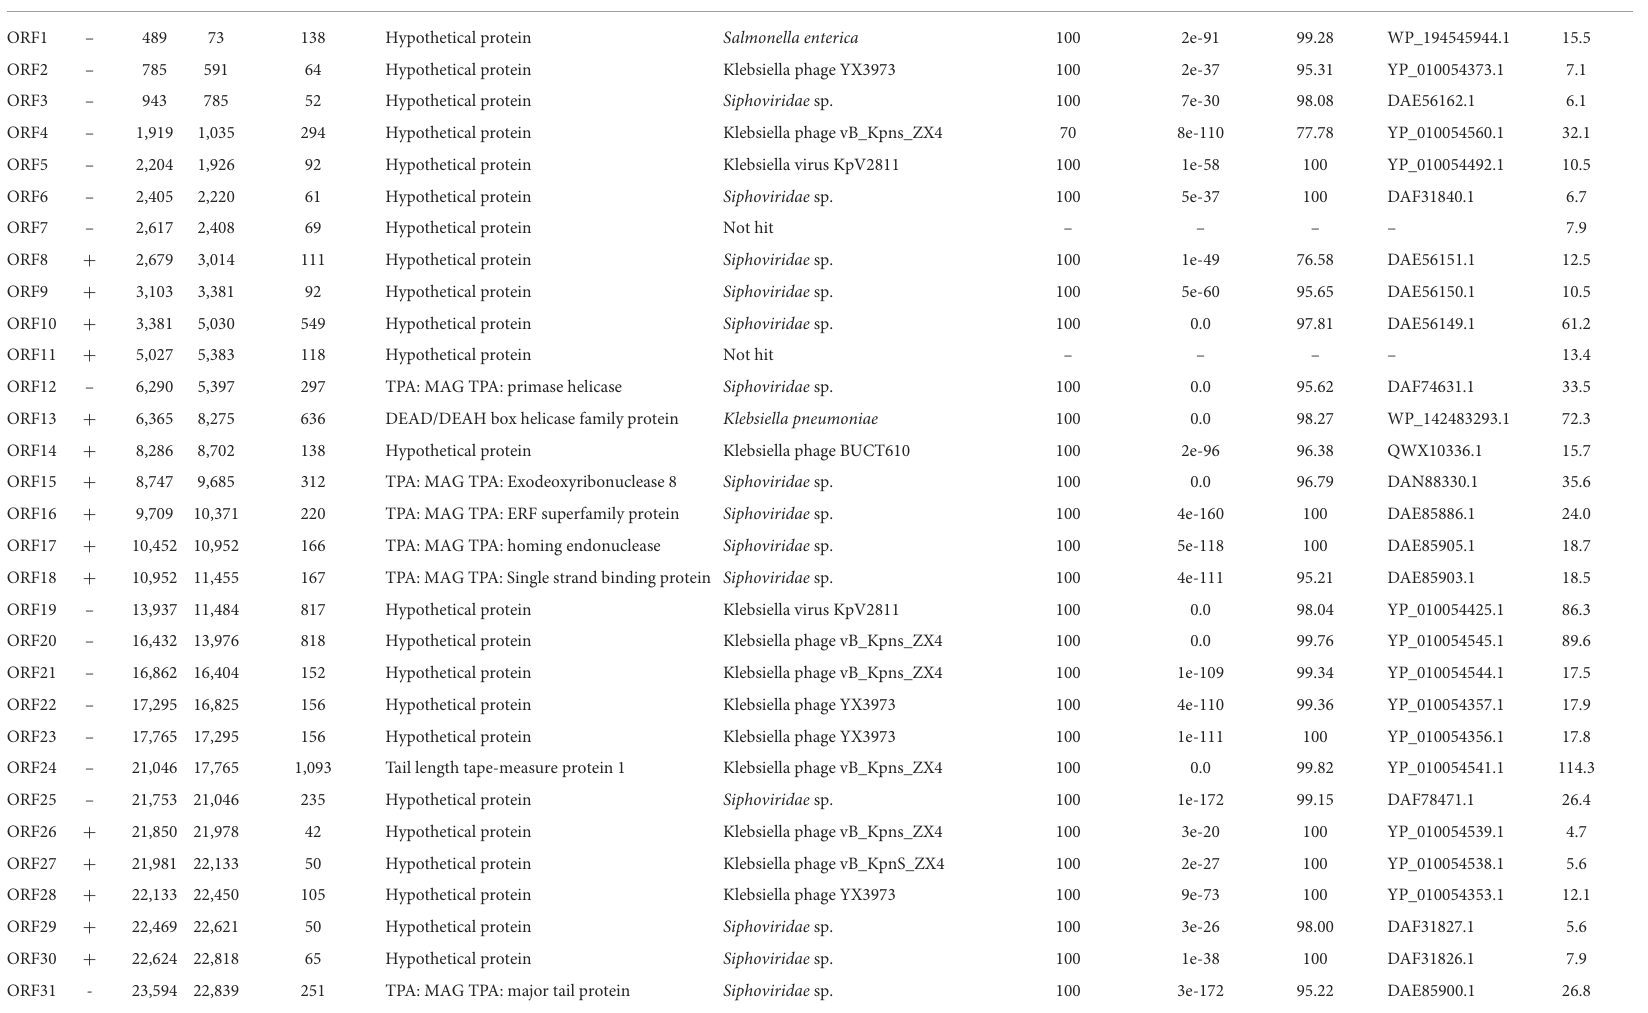
TABLE 2 Annotated ORFs in the genome of phage BUCT541. ORF Strand Start Stop Length (AA) Putative function Best-match BLASTp result Query cover (%) E-values Identity (%)